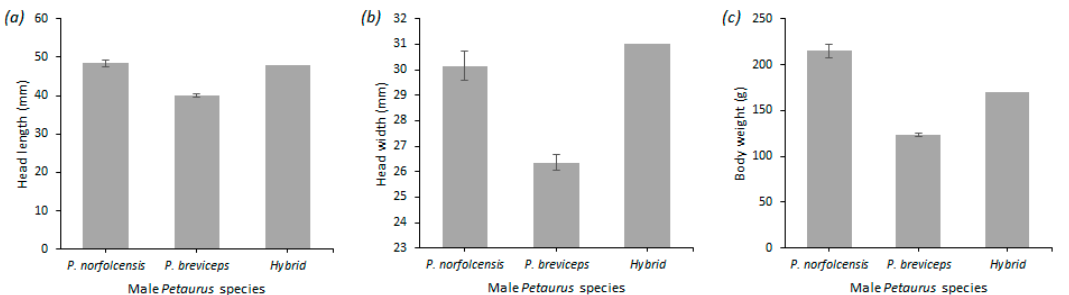
Figure 3. Mean morphological measurements of 23 male adult squirrel gliders ( P. norfolcensis ) and 47 male adult sugar